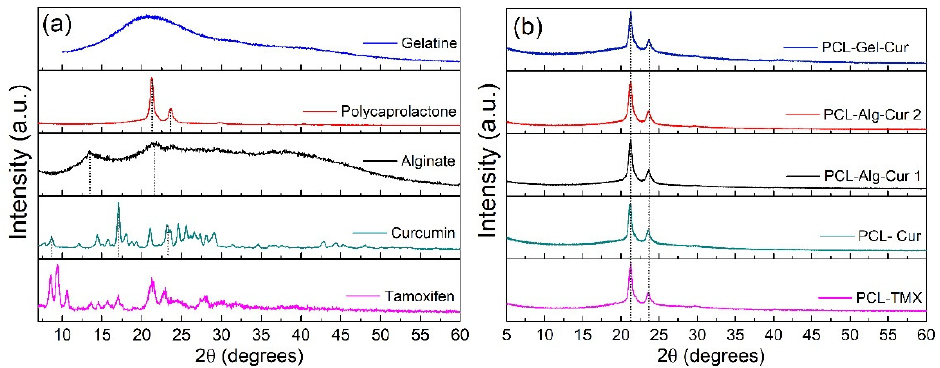
Figure 4. XRD diffractogram for ( a ) the starting materials and ( b ) the uniaxial and coaxial nanofibers. Arbitrary units (a.u.)